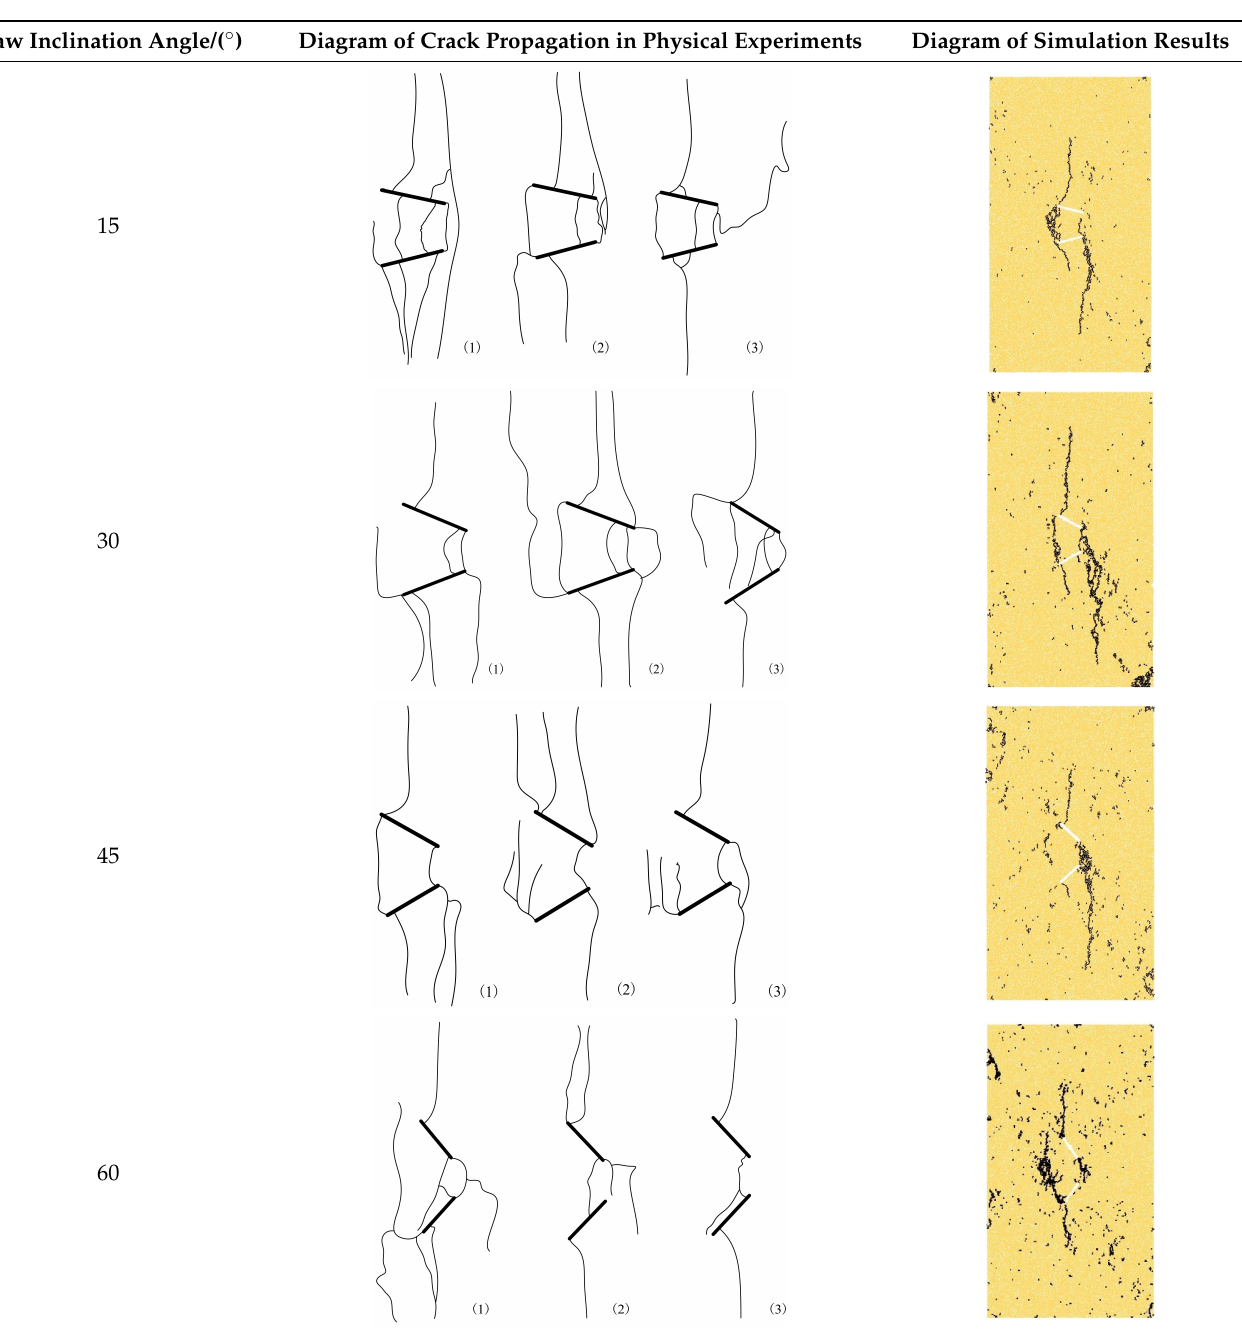
Table 3. Comparison of crack propagation results between laboratory experiment [22] and numerical